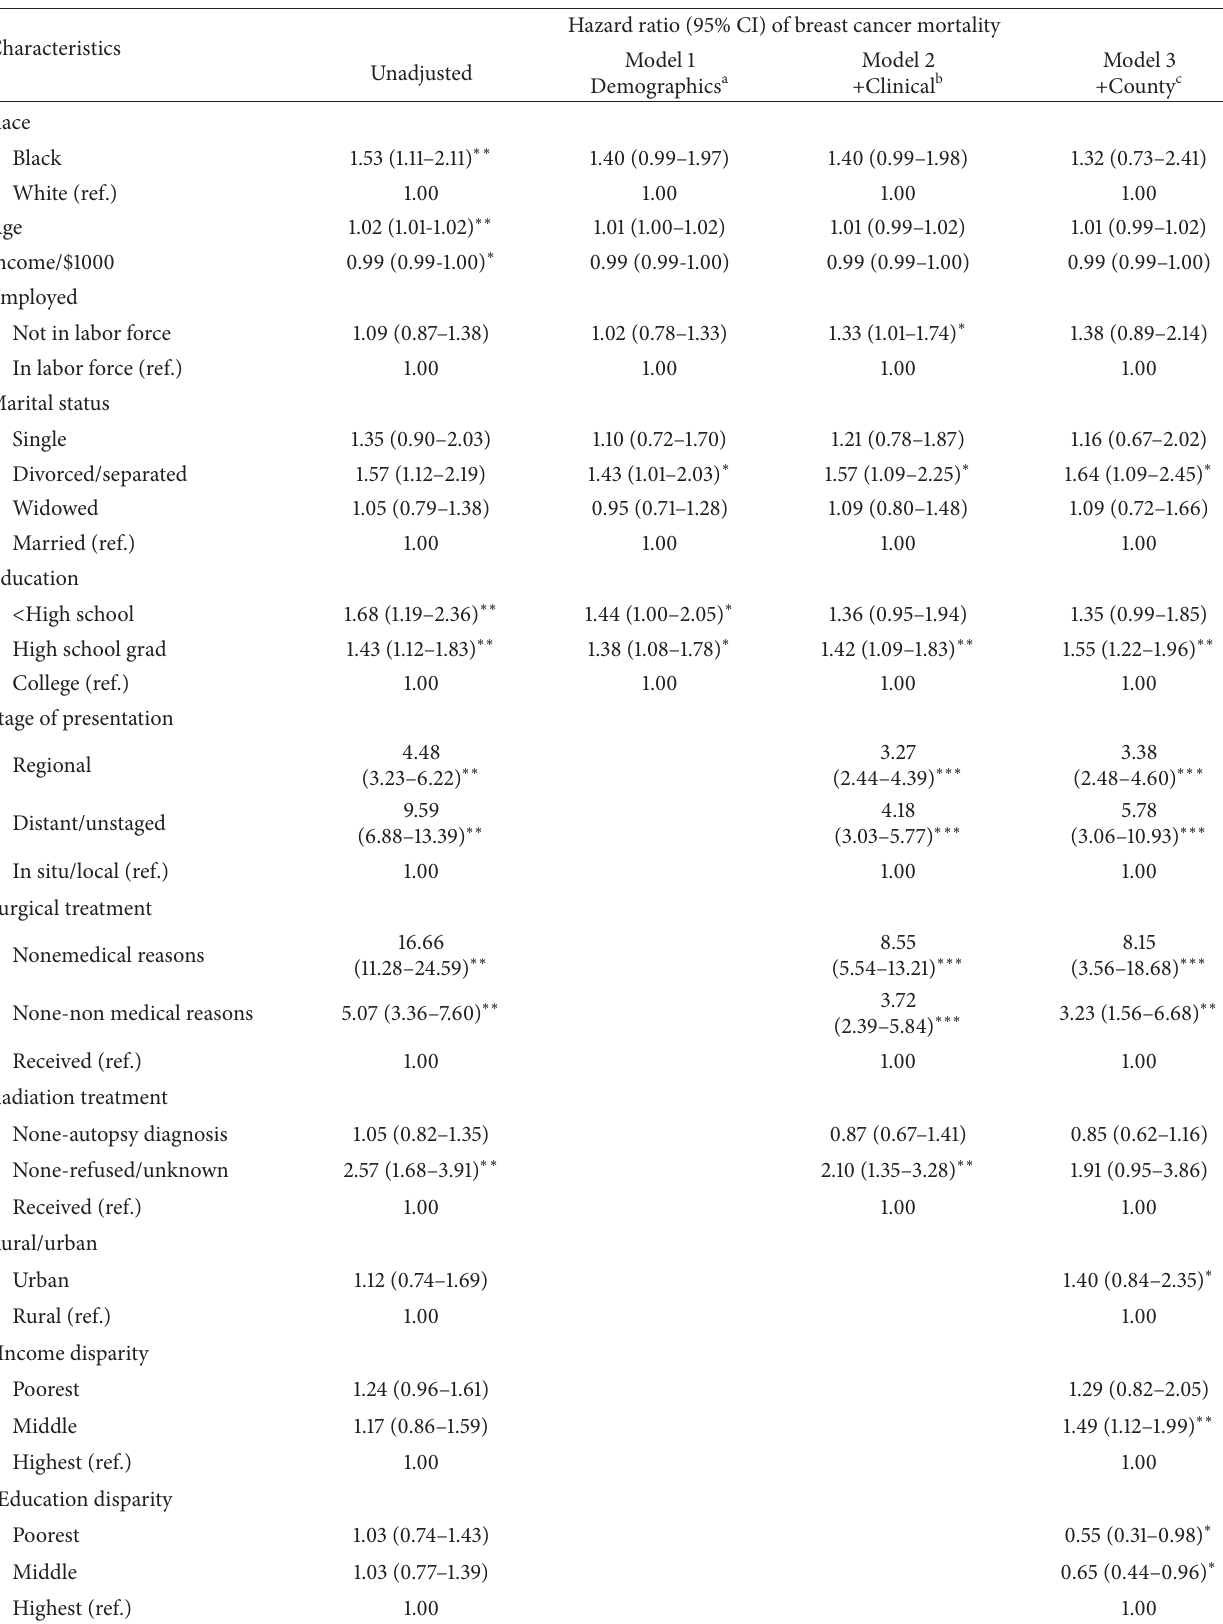
Table 3: Cox Proportional Hazard analysis of breast cancer mortality, SEER-NLMS,